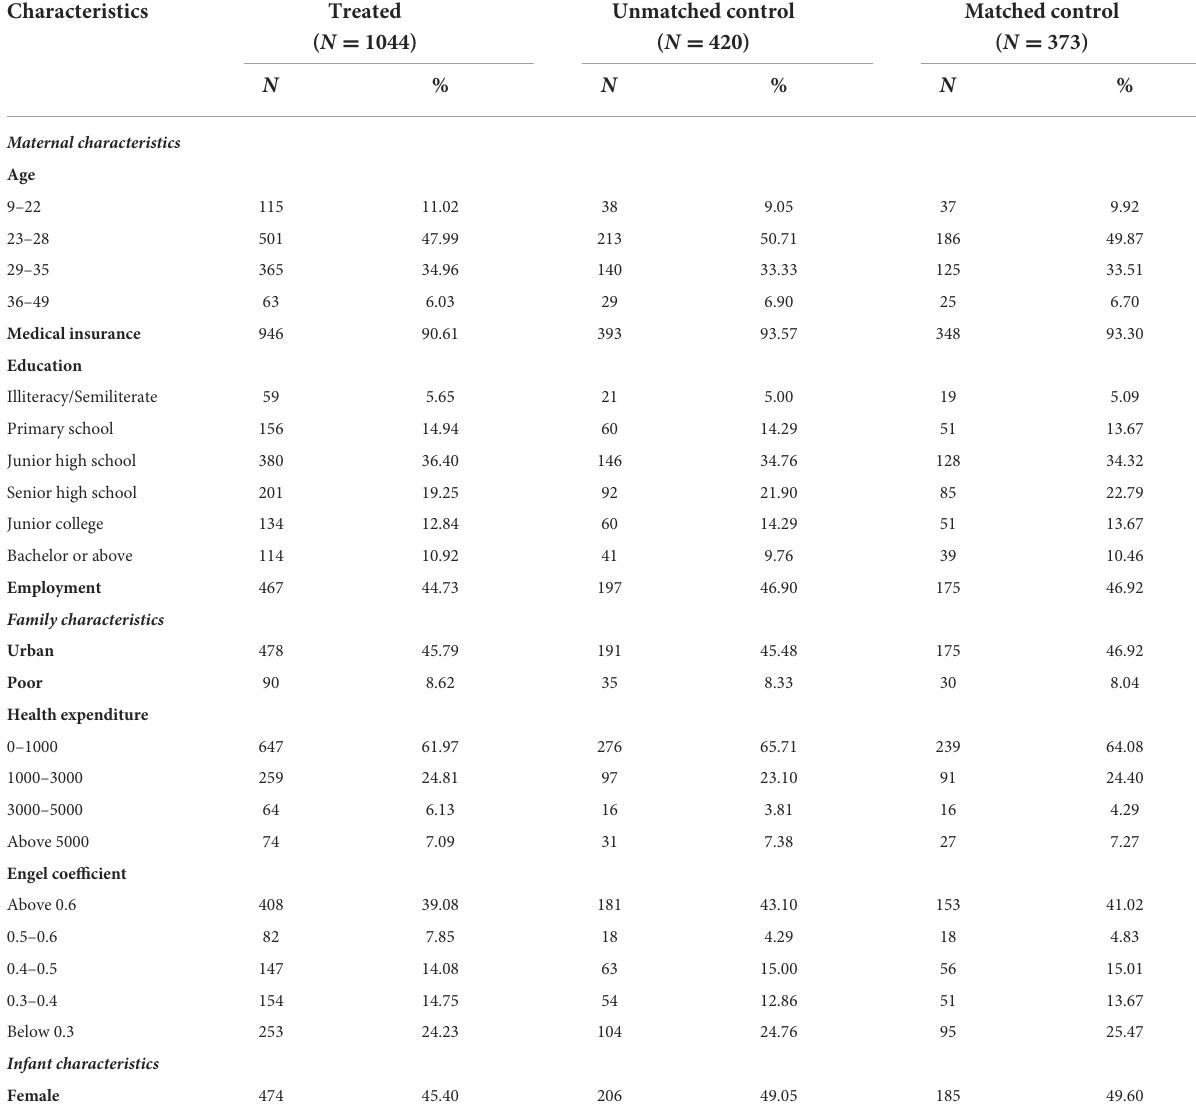
TABLE 4 Descriptive statistics of the covariates for study samples in the contemporaneous group.